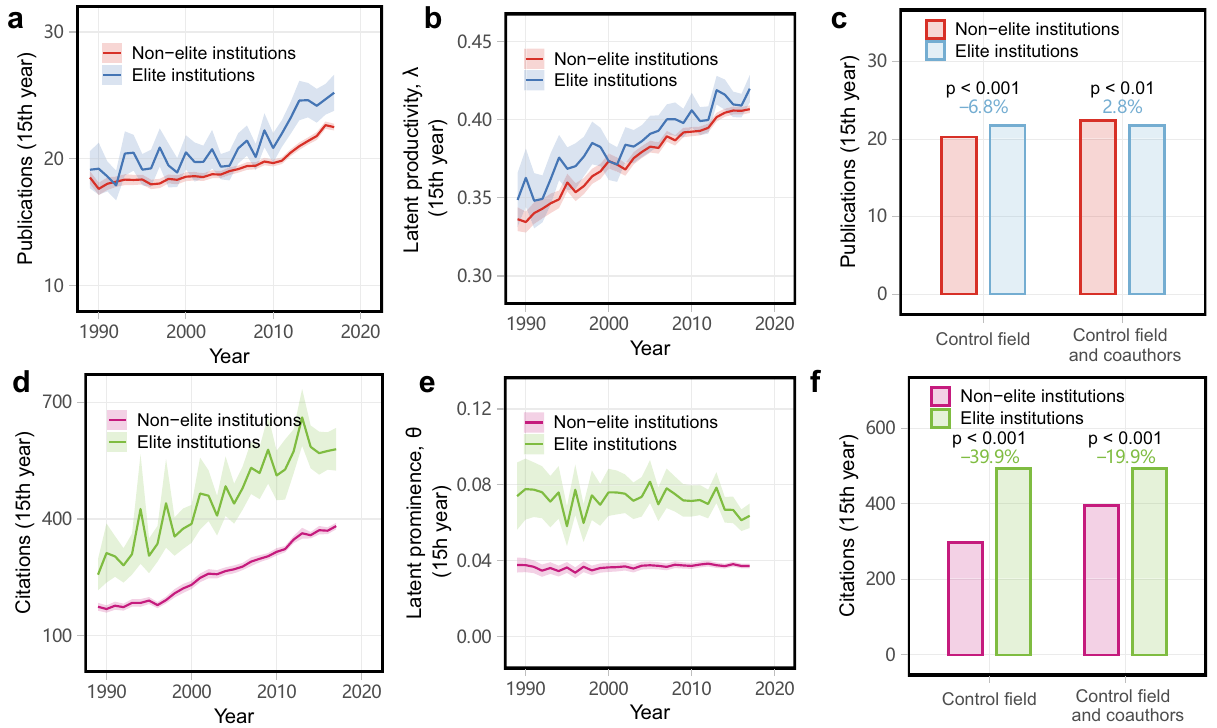
Fig. 4 | Impact of elite environments on researcher productivity and promi- nence. The institution-based differences in unadjusted average ( a ) productivity and ( d ) impact, and in latent variables ( b ) λ and ( e ) θ of mid-career researchers. Shaded areas indicate 95% con fi dence intervals. Then, ( c ) productivity and ( f ) prominence for pairs of mid-career researchers matched on institutional prestige,